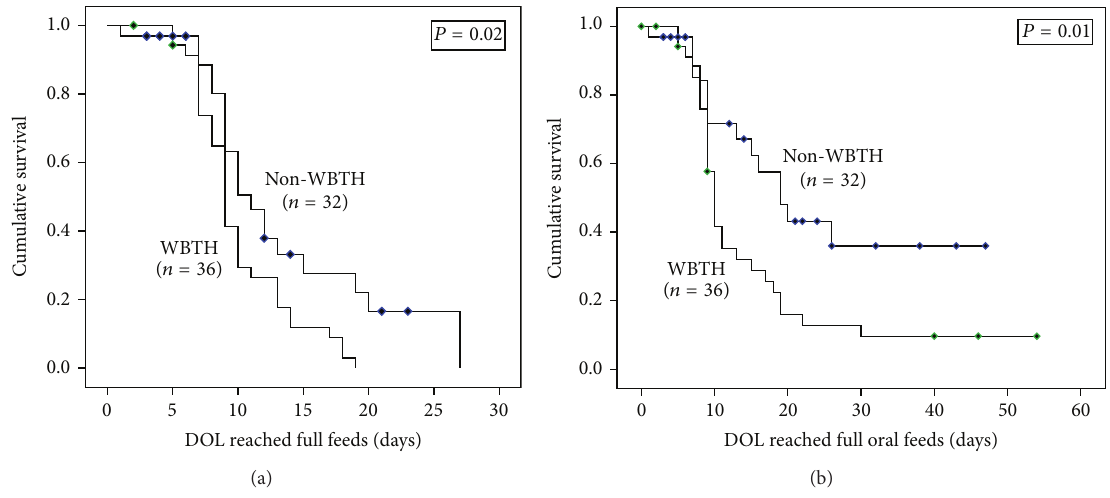
Figure 2: Survival curves for subjects with strict criteria ∗ . ∗ Censored subjects are